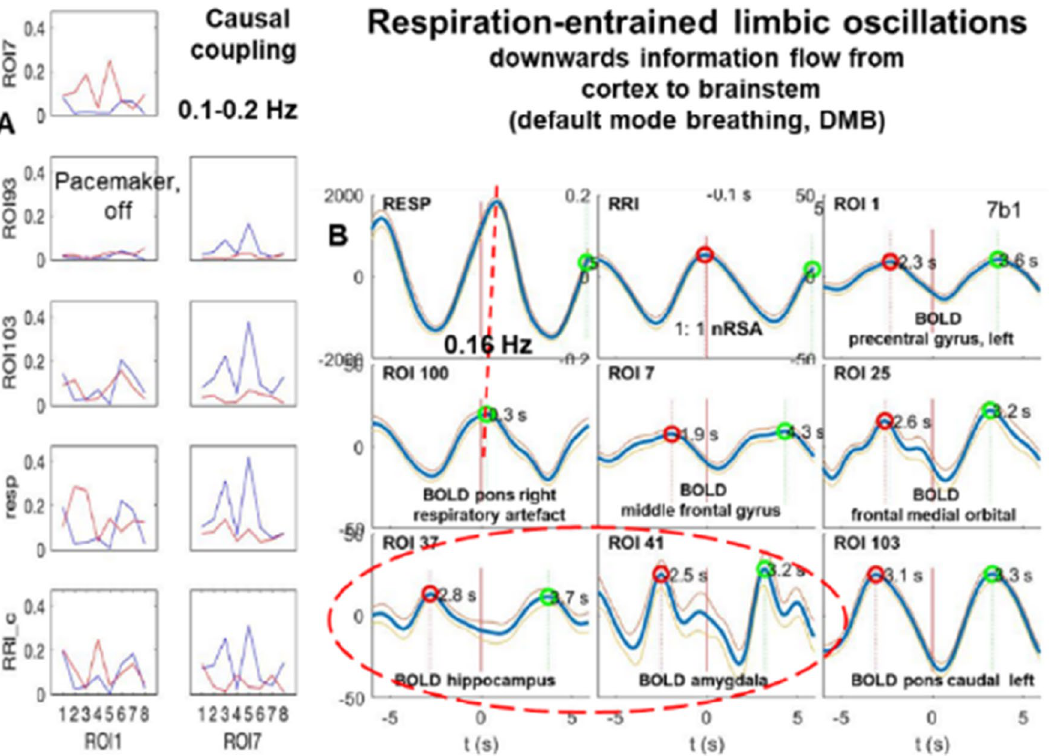
Figure 4. ( A ) Results of DTF analyses. In each box ffDTF as a function of consecutive eight time windows of 40 s length is shown. Blue lines: outflow from the structure marked below the box to the structure marked at the left, red lines: flow from structure marked at the left to this marked below (Modified from 17 ). ( B ) Examples of RRI peak triggered breathing and BOLD waves from a normal subject with low fMRI-related anxiety. For further explanation see Fig. 2. Note, the similarity of BOLD oscillation at ~ 0.16 Hz in limbic system (marked by stippled ellipses), prefrontal cortex (ROIs 1and 7) and brainstem. (ROI